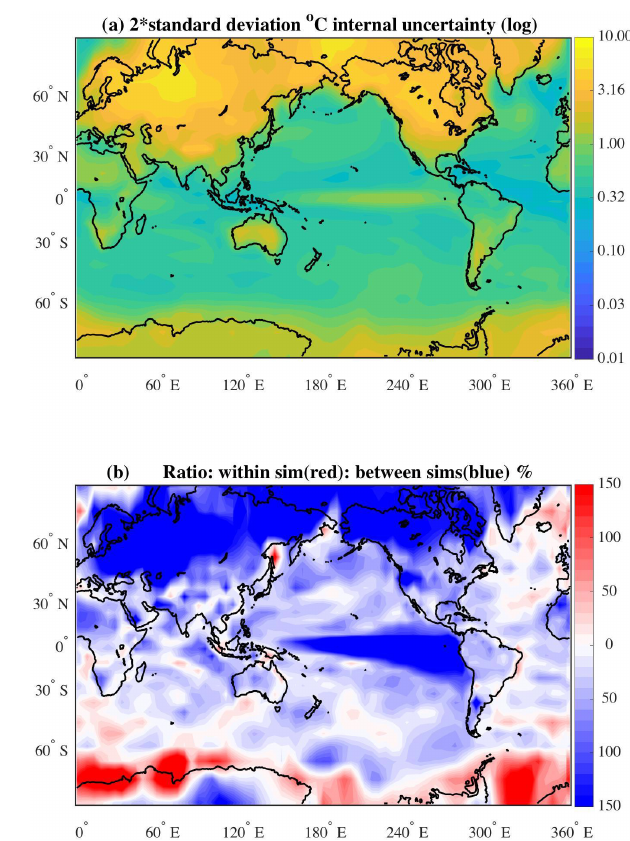
Figure 12. (a) Represents the uncertainty within the simulations (“internal”, Z (cid:48) ) for surface air temperature over all Decembers. (The shading is in terms of a log 10 value with tick marks labeled with unlogged values; compare to Fig. 3b.) (b) Ratio temperature uncer- tainty in Fig. 12a ( Z (cid:48) ) and Fig. 3b ( Z ∗ ). Let Z 1 = X − Y , where X represents the spatial field for a month from the coupled ensemble and Y represents the same for the ocean-only ensemble. In all cases the atmospheric ini- tial conditions are the same. In each pair, both the ocean-only